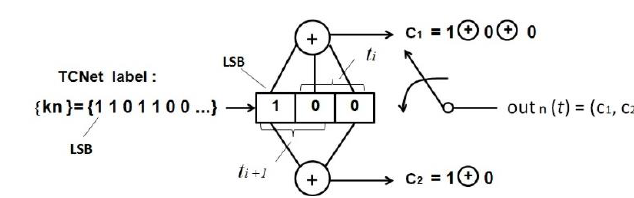
Figure 3. Example of a MM with the input sequence {k n } generating an output sequence out n (t) = (c 1 ,c 2 )